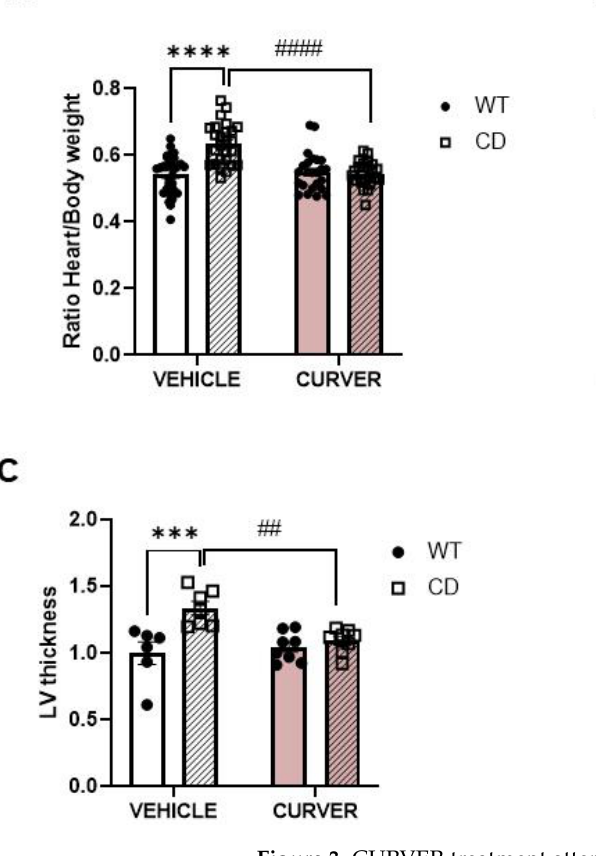
Figure 3. CURVER treatment attenuates cardiac hypertrophy in CD mice. ( A ) Cardiac hypertrophy ( p < 0.0001) did not develop following CURVER administration, subsequently preventing the ac- companied enhanced heart weight ( p = 0.9995). ( B ) Representative histopathological images of hearts evaluated in ( C ) stained with haematoxylin-eosin. ( C ) The significantly increased thickening of the left ventricular wall identified in CD-vehicle mice ( p = 0.0009) was normalised following CURVER treatment ( p = 0.5941). Data are represented as mean ± SEM. Two-way ANOVA with Tukey’s multiple comparisons test. * Effect of genotype; #, effect of treatment. ## p < 0.005; *** p < 0.001; ****, #### p < 0.0001. 2.4. Parallel Reduction Levels of Aortic and Cardiac XOR and Oxidative Stress Markers after CURVER Treatment Due to the relevant role that oxidative stress plays in the development of cardiovas- cular disease in WBS, we wanted to investigate whether the mechanism(s) by which CURVER treatment prevented the formation of vascular stenosis and cardiac hypertrophy was related to oxidative stress pathways. XOR, as an important ROS source, plays im- portant roles in a variety of pathophysiological states in the cardiovascular system, in- cluding